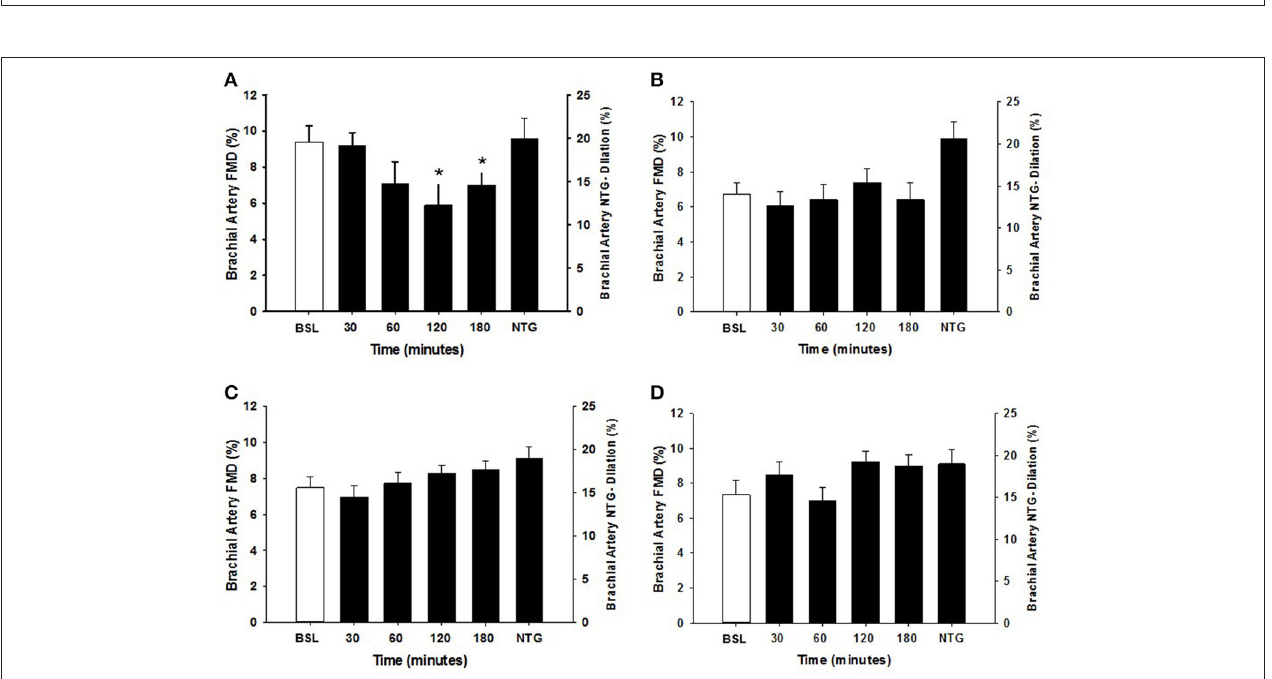
FIGURE 3 | Brachial artery FMD responses to a high fat mixed meal (HFMM) at baseline, and 30, 60, 120, and 180min post-ingestion in (A) sedentary participants ( n = 11), (B) runners ( n = 12), (C) weight lifters ( n = 13), and (D) cross-trainers ( n = 9). Brachial artery FMD scale is on the left Y-axis. Nitroglycerin (NTG) mediated dilation depicted on the right Y-axis. All data presented as mean ± SEM. *Indicates significant difference compared to baseline FMD measure (adjusted P < 0.05; Sidak-Bonferroni adjustment for ANOVA multiple comparisons).